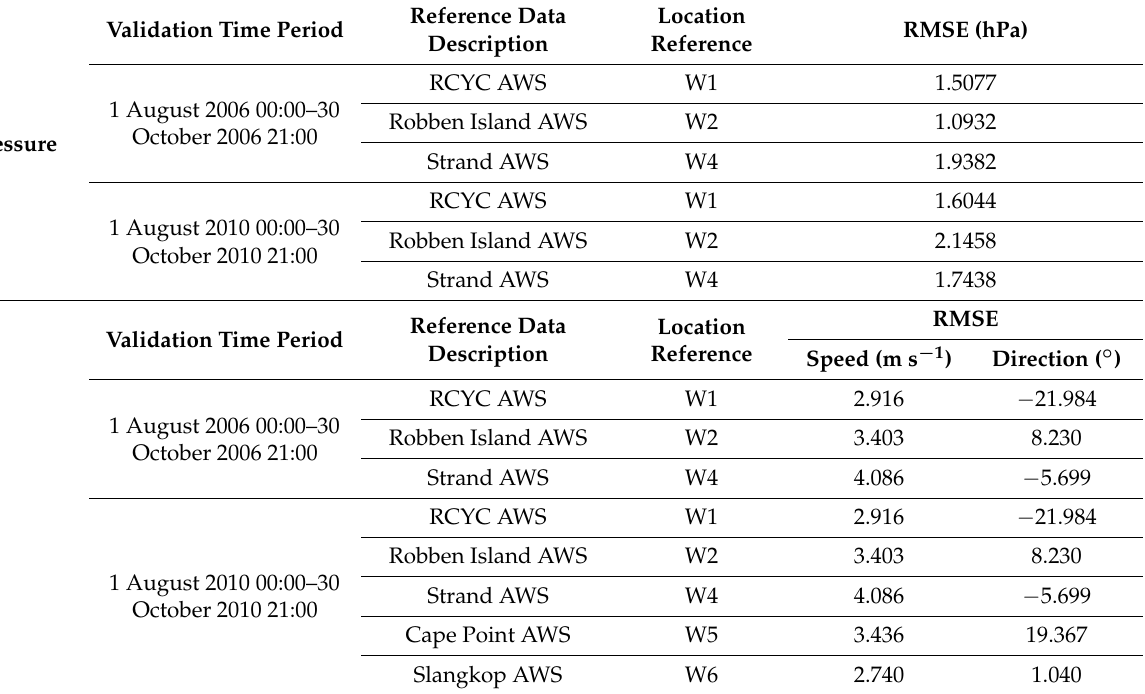
Table A1. Summary of validation statistics for the wind and pressure forcing applied to the HRM. Refer to Figure 1 for location references. Wind direction error metrics are not true RMSEs, but rather a mean angular difference for the entire time series.